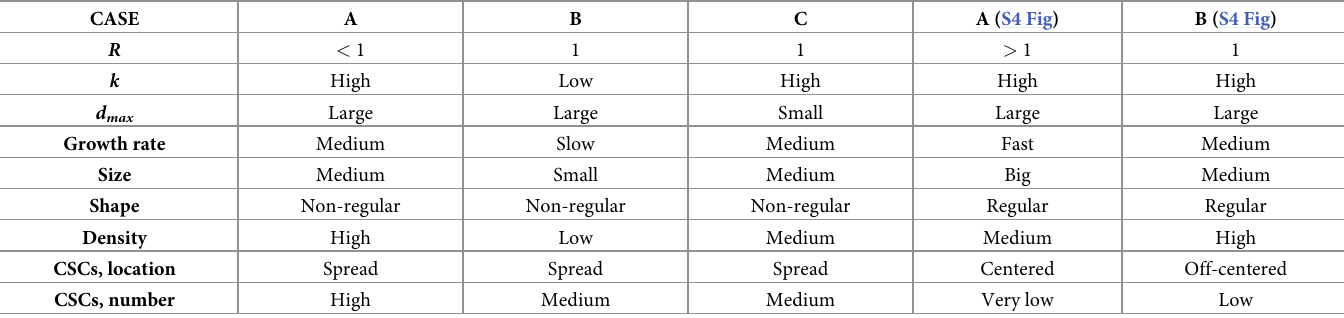
. Cases A-C correspond to panels A-C, max